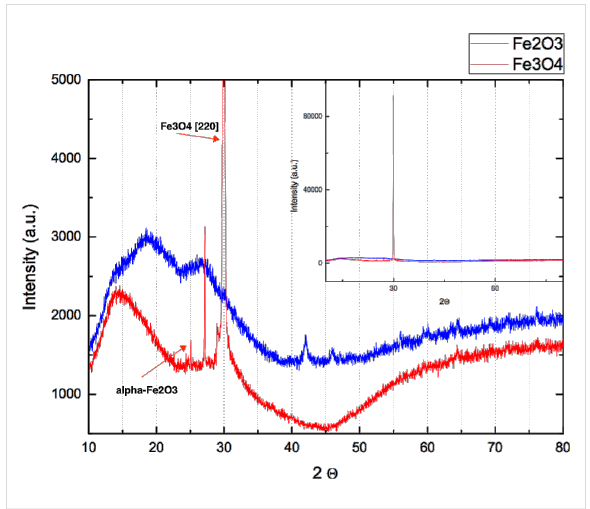
Four different antidot arrays have been patterned, combining two symmetries (hexagonal and square order) with two differ- ent lattice constants (240 and 360 nm), as shown in Figure 2c–f. Figure 3: XRD patterns of the as-deposited Fe 2 O 3 film (blue curve) and the Fe 3 O 4 film (red curve) after the thermal reduction